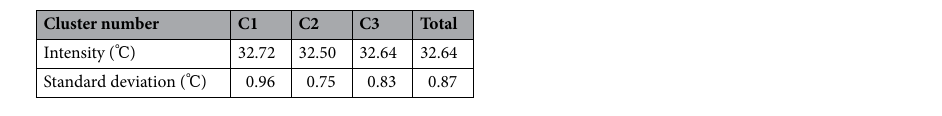
Table 1. Mean intensity and standard deviation for the three SOM cluster